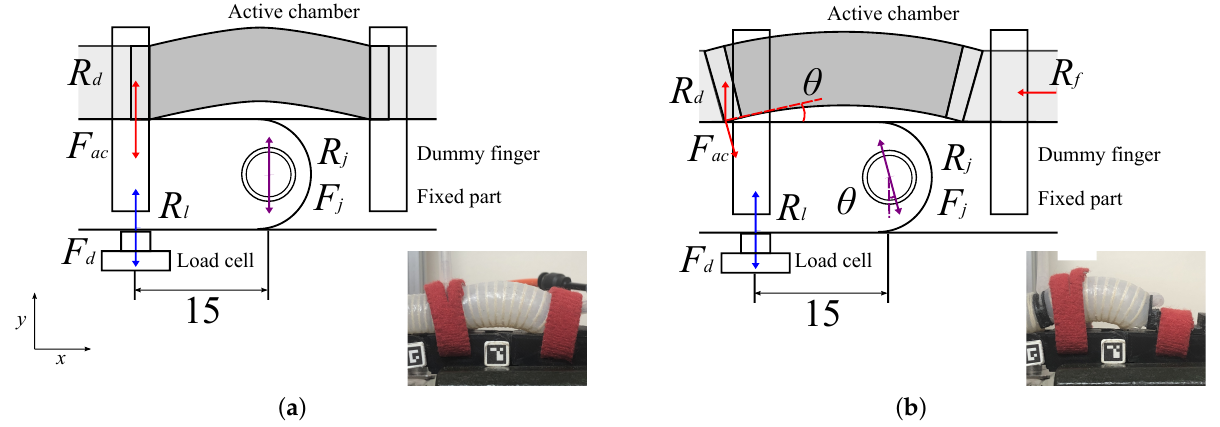
Figure 15. Free body diagrams and experimental setting. ( a ) Right size selected; ( b ) different size